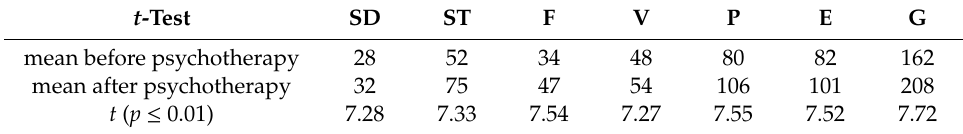
Table 1. The t -test on indicators of subjects’ existential fulfillment. t